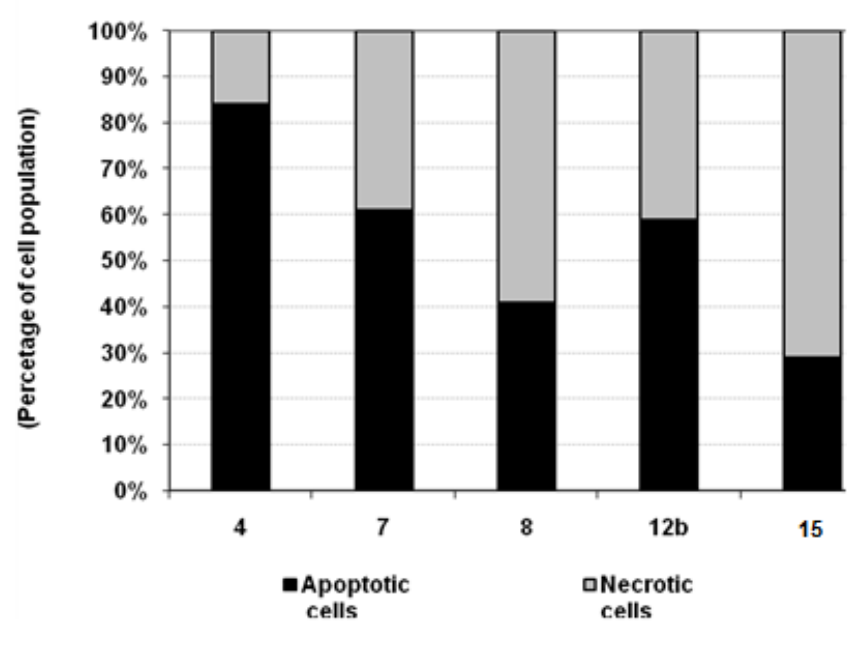
Table 4. Percentage of induced apoptotic and necrotic cells in HCT-116 Cells. Compd.